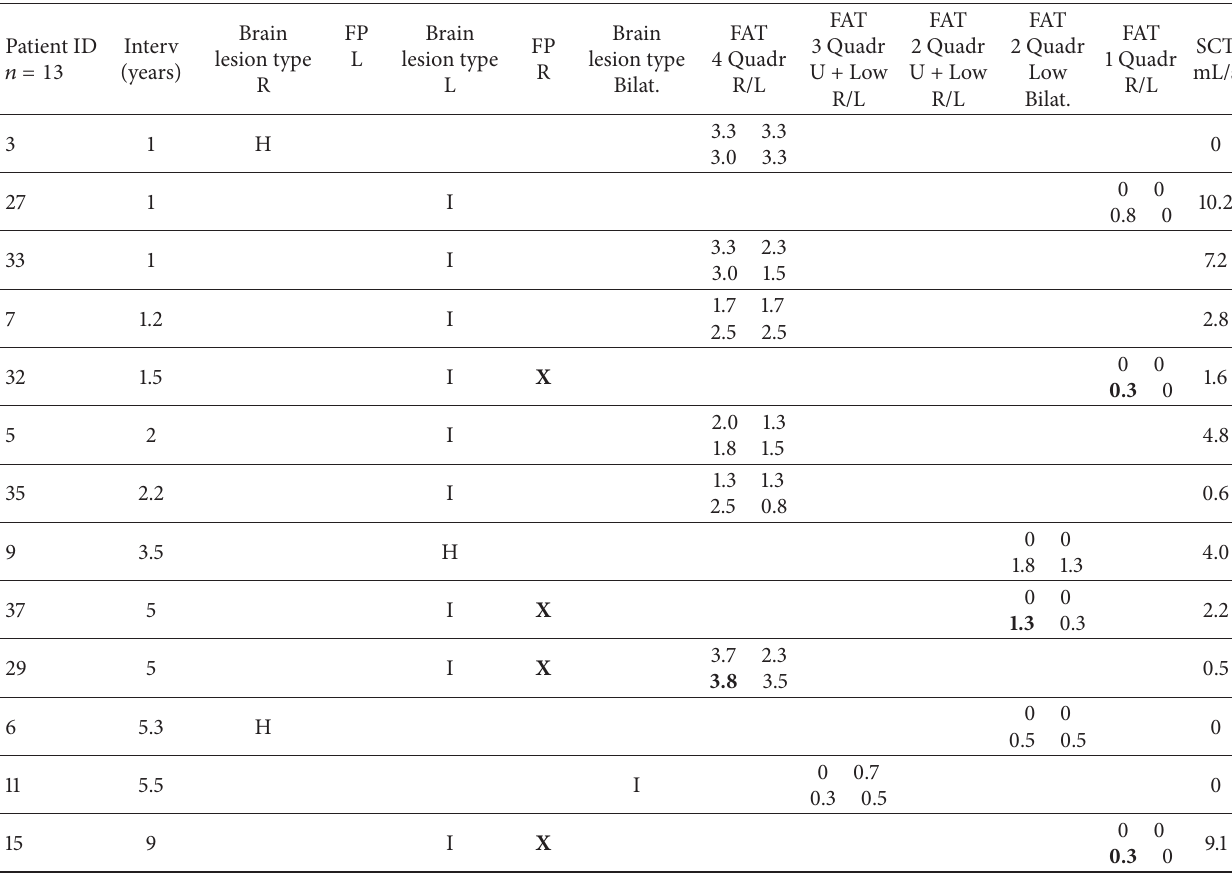
Table 3: Four-quadrant (upper, lower, right, and left) facial function in Group C (status years after stroke). Individual data are given for each patient with stroke and dysphagia ( 𝑛 = 13